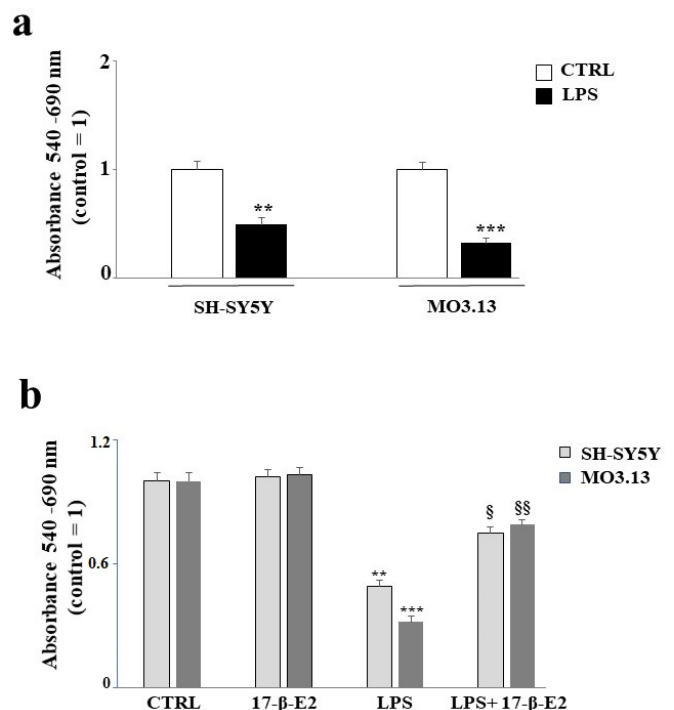
Figure 2. The 17 - beta estradiol (17- β -E2 ) protects oligodendrocytes and neurons from LPS-induced damage. Figure 2 (panel ( a ) shows the extent of the viability reduction induced by the LPS treatment of co-cultured neurons and oligodendrocytes. In particular, the cell lines were treated with LPS at a concentration of 1 μ g/mL for 24 h, and at the end of treatment, the cells were subjected to an MTT test. A comparison between neurons and oligodendrocytes under these experimental conditions is shown. ( b ) The results related to co-treatment with 17- β -E2 and LPS. Both cell lines were pretreated with 1 μ M 17- β -E2 for 1 h. Without removing or changing the growth medium, the cell lines were exposed to LPS 1 μ g/mL for 24 h. Subsequently, cell viability was measured using an MTT assay. Three independent experiments were carried out, with values expressed as the mean ± standard deviation (sd). ** denotes p < 0.01 vs. the control; *** denotes p < 0.001 vs. the control. § denotes p < 0.05 vs. LPS; §§ denotes p < 0.01 vs. LPS. Analysis of Variance (ANOVA) was followed by a Tukey– Kramer comparison test.